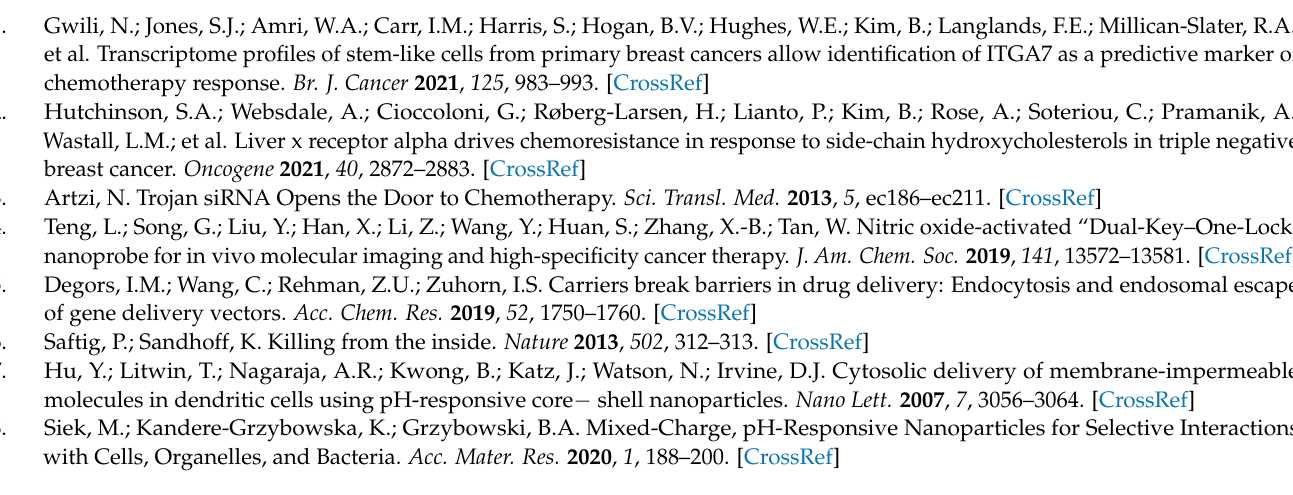
Figure S5: Photos of pH-dependent dissolution of Au 2 Re 6 -S (left) and Au 2 Re 6 -Se (right) colloids. incubated with different concentrations of Au 2 Re 6 -S (black lines), LSZ-Au 2 Re 6 -S (red lines), Au 2 Re 6